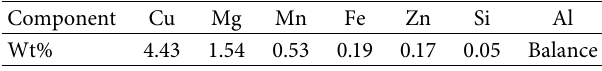
Table 1: AA2024—chemical